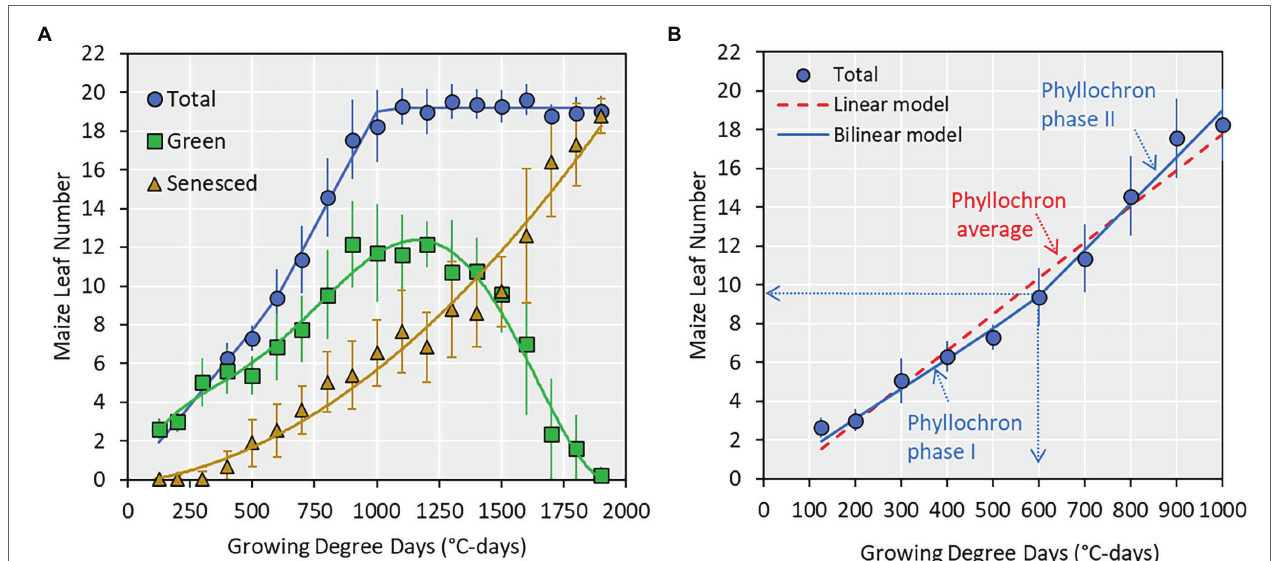
FIGURE 2 | (A) Relationship between collared maize leaf number and growing degree days (GDD; base of 8 ° C). Points indicate average values ± SE from all datasets and lines are best regression fits (not shown). (B) A subset of (A) showing total leaf number from emergence to silking and the two prediction models used in this study and the associated parameters. The vertical and horizontal dotted arrows indicate the transition point (e.g., 9 leaf number or 600 GDD) at which phyllochron transitions from phase I to phase